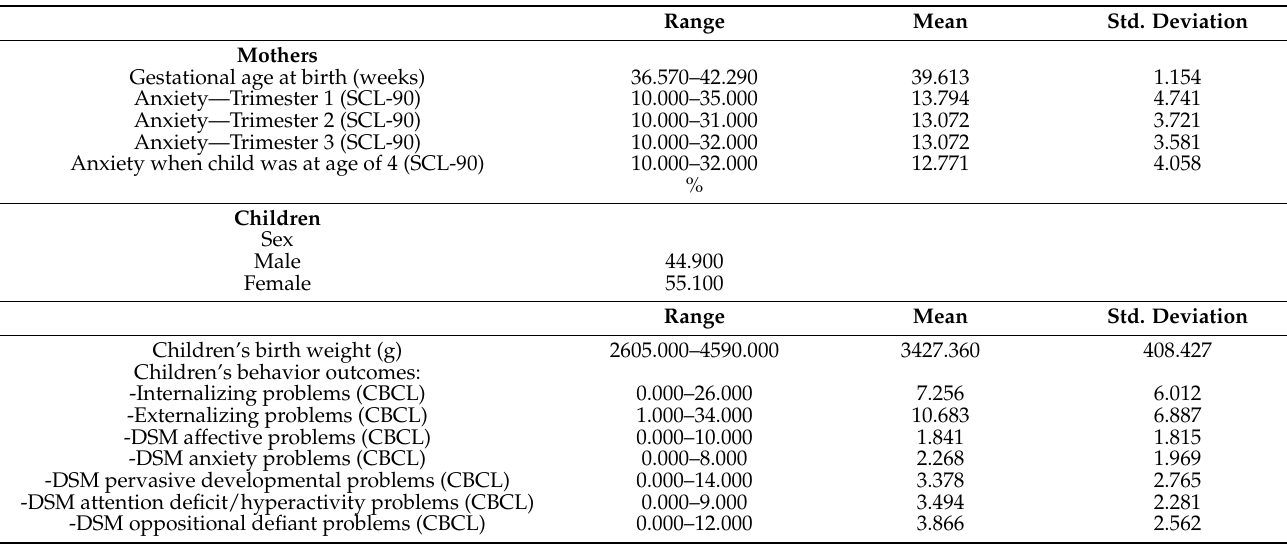
Table 1. Descriptive statistics of the mothers and children.